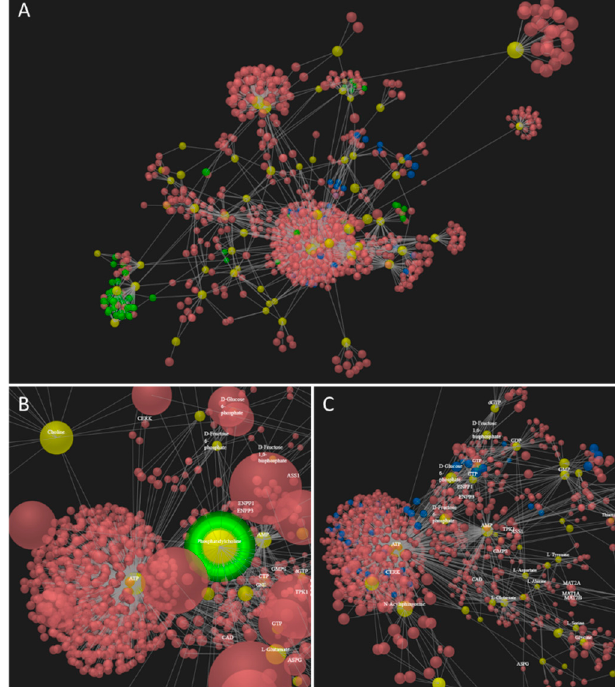
Figure 4. Multiomics network analysis of MSCs and adipocytes. Network analysis by OmicsNet [35] enabled to combine protein, metabolite, and lipid information, and identify regulated pathways in adipogenesis. ( A ) The network including most protein-metabolite interactions. Proteins are labeled in red and metabolites in yellow. The glycerophospholipid metabolism is labeled in green and the insulin pathway in blue. ( B ) Phosphatidylcholine as regulated lipid within the glycerophospholipid metabolism. ( C ) ATP and AMP as major regulated energy metabolites, additionally the insulin pathway is significantly regulated and labeled in blue.